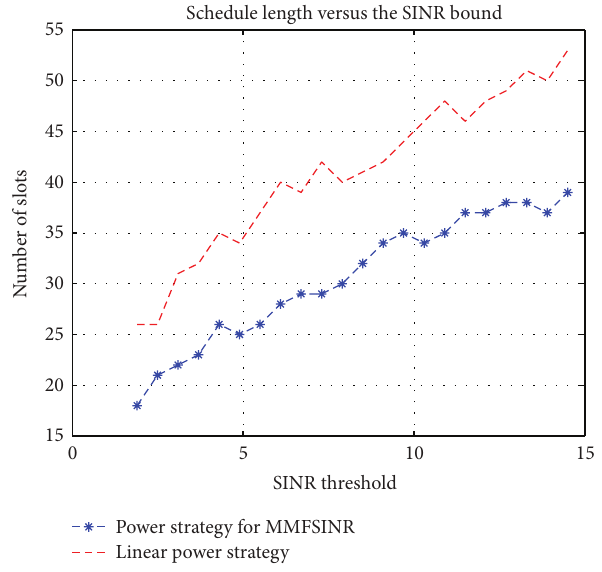
Figure 3: Time slots number versus